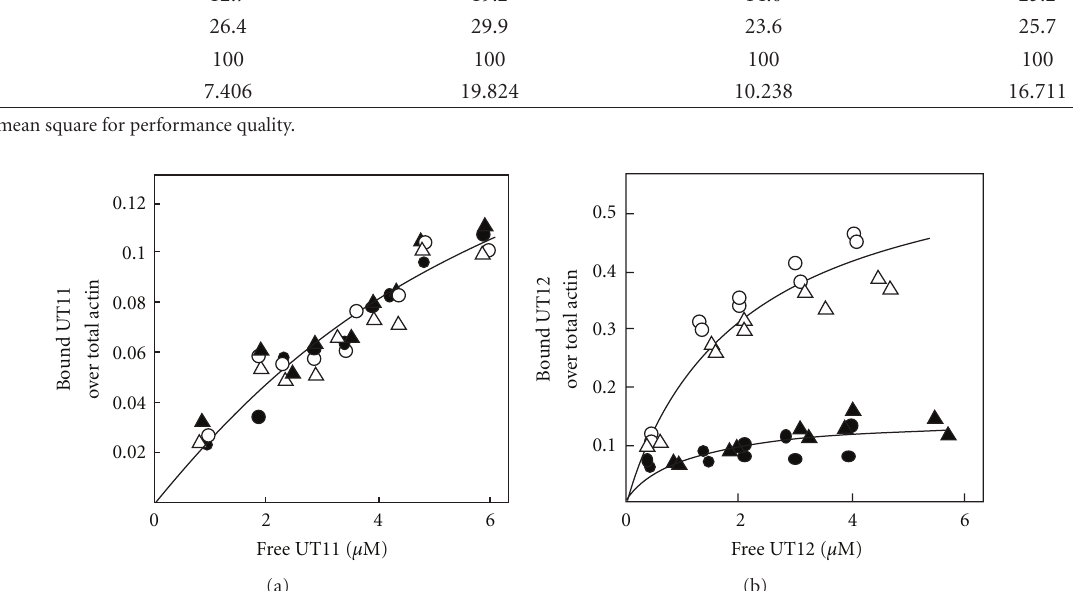
Figure 7: E ff ects of calmodulin and calcium on binding of UT11 and UT12 to actin. Calmodulin plus EGTA does not inhibit actin binding (open symbols). Calmodulin plus Ca 2+ (black symbols) does not inhibit actin binding of UT11 (a), but binding of UT12 is inhibited (b). Incubation conditions: (O) Ca 2+ 1mM; ( (cid:2) ) calmodulin 0.2 mM plus EGTA 1mM; ( • ) calmodulin 0.2mM plus Ca 2+ 1mM; ( (cid:3) ) calmodulin 0.2mM, Ca 2+ 2mM plus EGTA 1mM (for further explanation see the